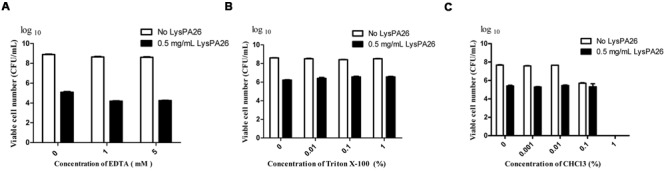
The synergistic antimicrobial activity assay of LysPA26 and OMPs. (A) The effect of the concentration of EDTA on the lytic activity of LysPA26. The antimicrobial activity of LysPA26 (0.5 mg/ml) was checked under different concentrations of EDTA (0, 1, 5 mM). (B) The effect of the concentration of Triton X-100 on the lytic activity of LysPA26. The antimicrobial activity of LysPA26 (0.5 mg/ml) was checked under different concentrations of Triton X-100 (0, 0.01, 0.1, 1%). (C) The effect of the concentration of CHCl3 on the lytic activity of LysPA26. The antimicrobial activity of LysPA26 (0.5 mg/ml) was checked under different concentrations of CHCl3 (0, 0.001, 0.01, 0.1, 1%). After 30 min of incubation, the residual viable cells were plated and the decrease in viable bacterial numbers measured. Error bars represent the standard deviations of three independent assays.